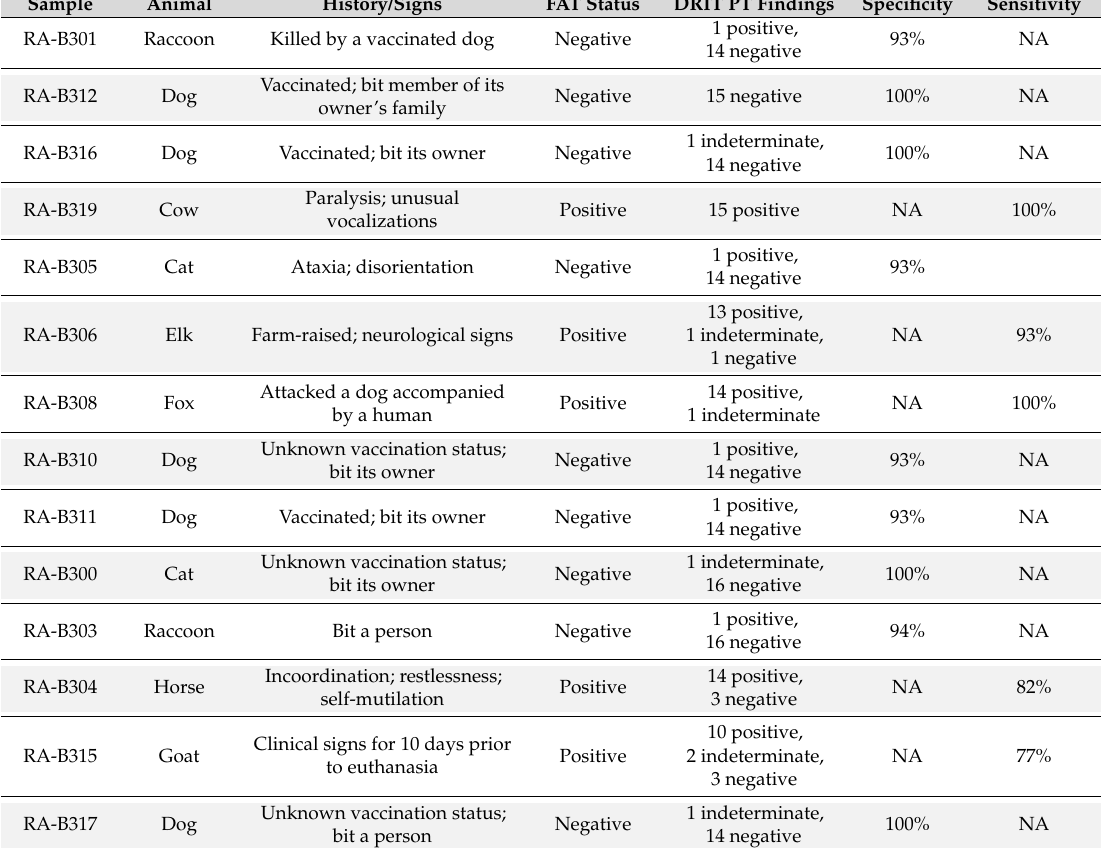
Table 3. U.S. National Proficiency Test (PT) Results of DRIT comparison to the FAT. Samples : Brain tissue of suspect mammals (n = 27), as described in the history. Testing : 2015–17 PT period. Protocol: Original DRIT SOP as described and performed by USDA, Wildlife Services staff and 1 state laboratory (12 to 17 participating facilities). MABs: Cocktail MAB 502 + MAB